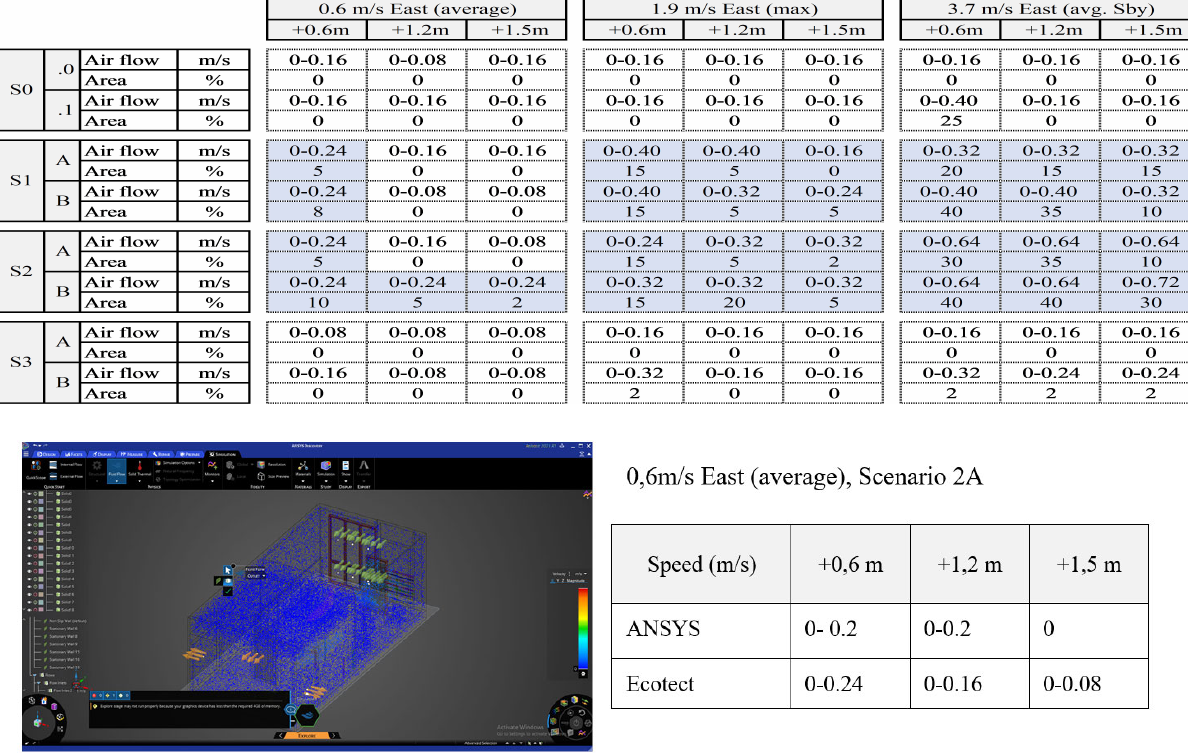
Fig. 6. Simulation using ANSYS Discovery 2021 and Comparation to Ecotect